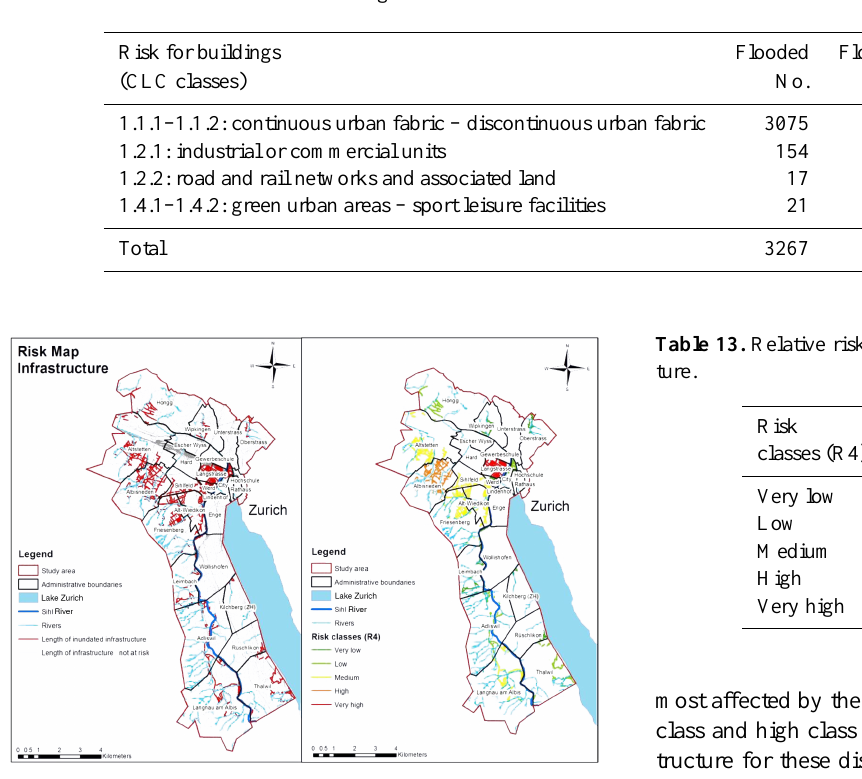
Figure 7. Exposure (left) and relative risk (right) map for infras- tructure (roads, railways, pathways).